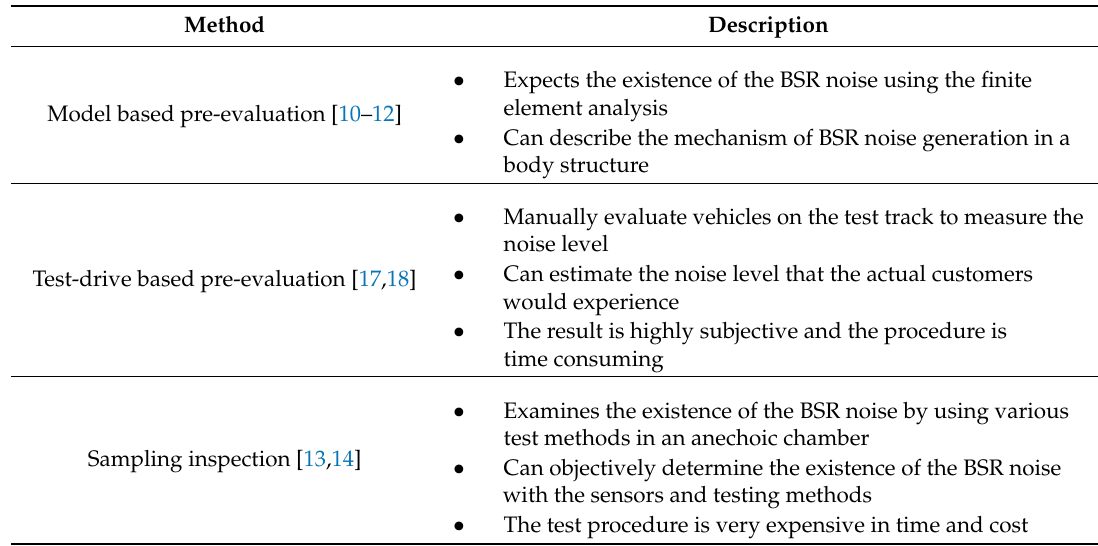
Table 1. Comparison of the BSR noise inspection